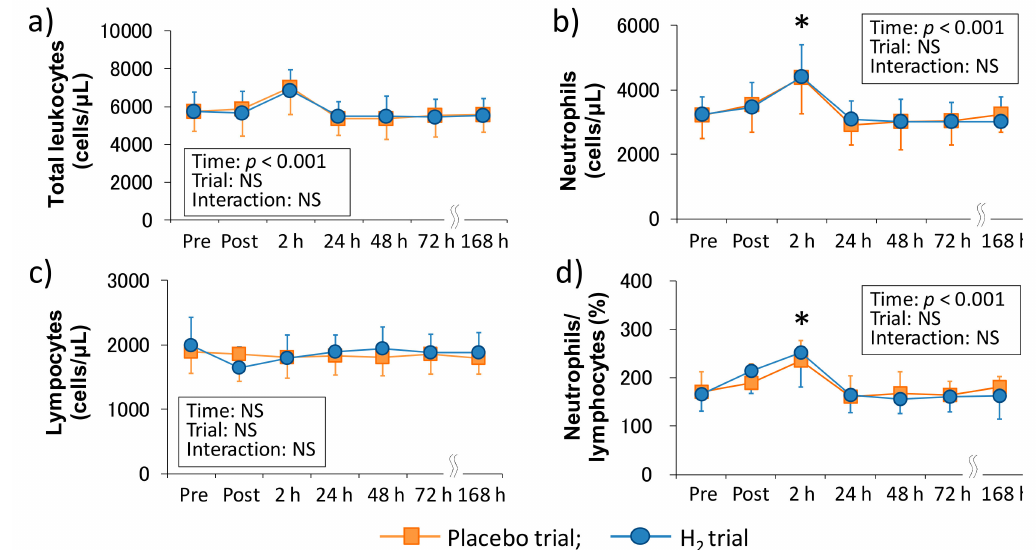
Figure 1. Time-course changes of peripheral leukocyte counts after downhill running. ( a ) Total leukocyte count, ( b ) Neutrophil count, ( c ) Lymphocyte count, and ( d ) Neutrophils/lymphocytes ratio. Pre, Pre exercise; Post, approximately 40 min after exercise (end of bath), 2, 24, 48, 72, and 168 h after exercise. Data are presented as the means ± standard deviations (SD) of nine subjects in each trial (placebo: n = 9, H 2 trial: n = 9). There was a significant time effect in the total leukocyte count ( p < 0.001), neutrophil count ( p < 0.001), and neutrophils/lymphocytes ratio ( p < 0.001) (two-way ANOVA for repeated measures). * indicates a significant change from the baseline value.